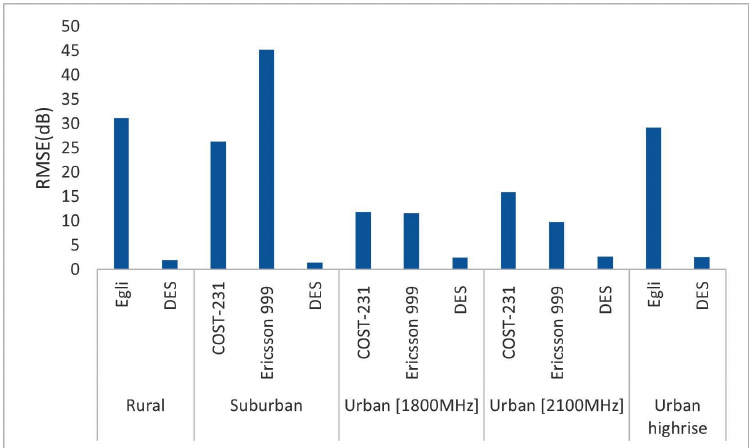
Figure 21. RMSE values of empirical models in various environments.